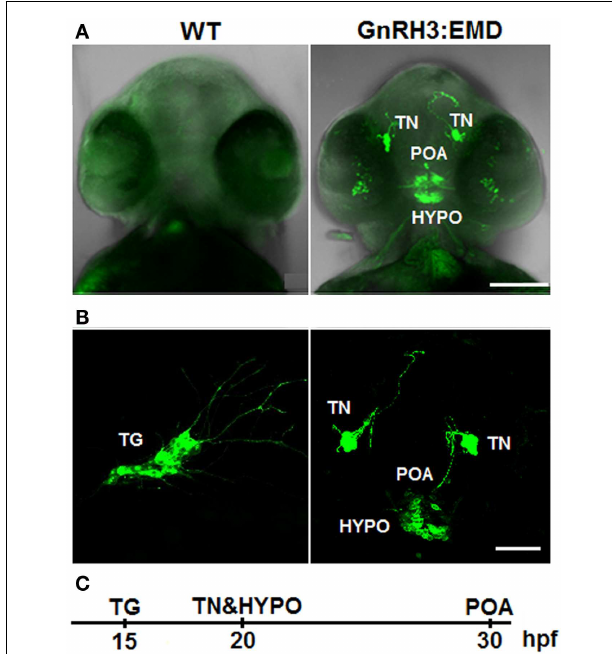
FIGURE 1 | Expression of GnRH3:EMD in live zebrafish embryos. (A) Z -stack projection of confocal images of wildtype (WT) and GnRH3:EMD embryos at 40 hpf (ventral view). GFP and brightfield images were merged so that the head is visible. (B) GFP confocal images of multiple populations of GnRH3:EMD-expressing neurons. Left: lateral view of GnRH3:EMD neurons expressed in the trigeminal ganglion (TG) at 20 hpf. Right: ventral view of GnRH3:EMD neurons expressed in terminal nerve (TN), preoptic area (POA), and hypothalamus (HYPO) at 30 hpf stage. (C) Timeline of the GnRH3:EMD neurons’ emergence. Scale bar: (A) 100 µ m; (B) 50 µ